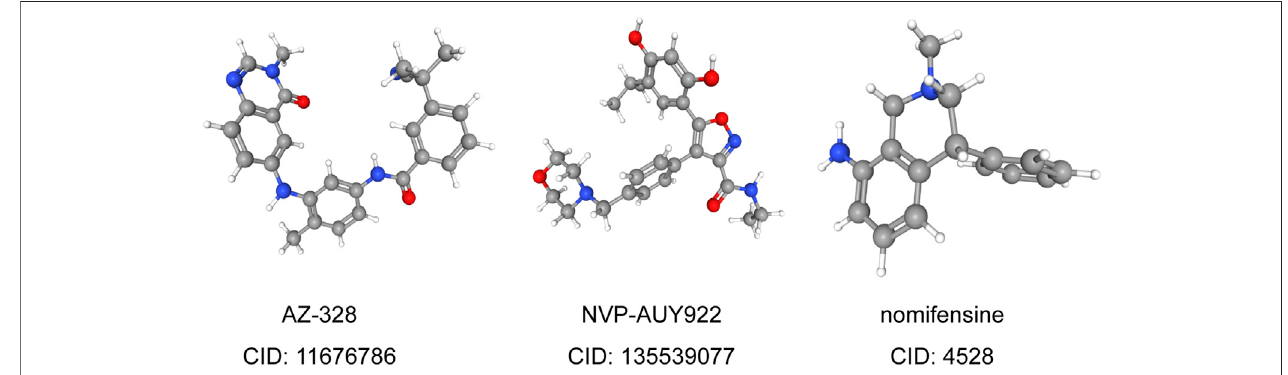
FIGURE 7 | 3D conformer of most signi fi cant small molecule